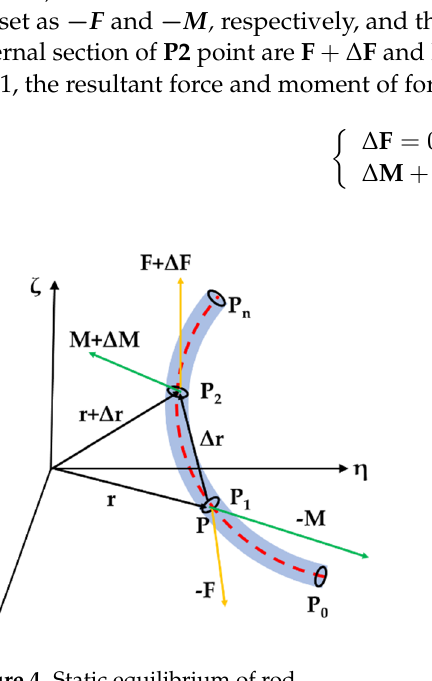
Figure 4. Static equilibrium of rod.